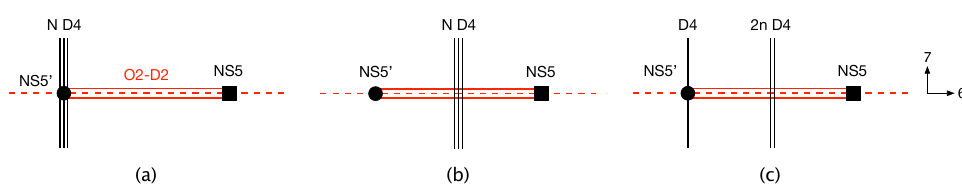
Figure 5 . Type IIA brane con(cid:12)guration for O ( K ) and USp(2 k ). For O ( K ) with an odd number of (cid:13)avors one D4-brane must remain broken on the NS5’-brane.